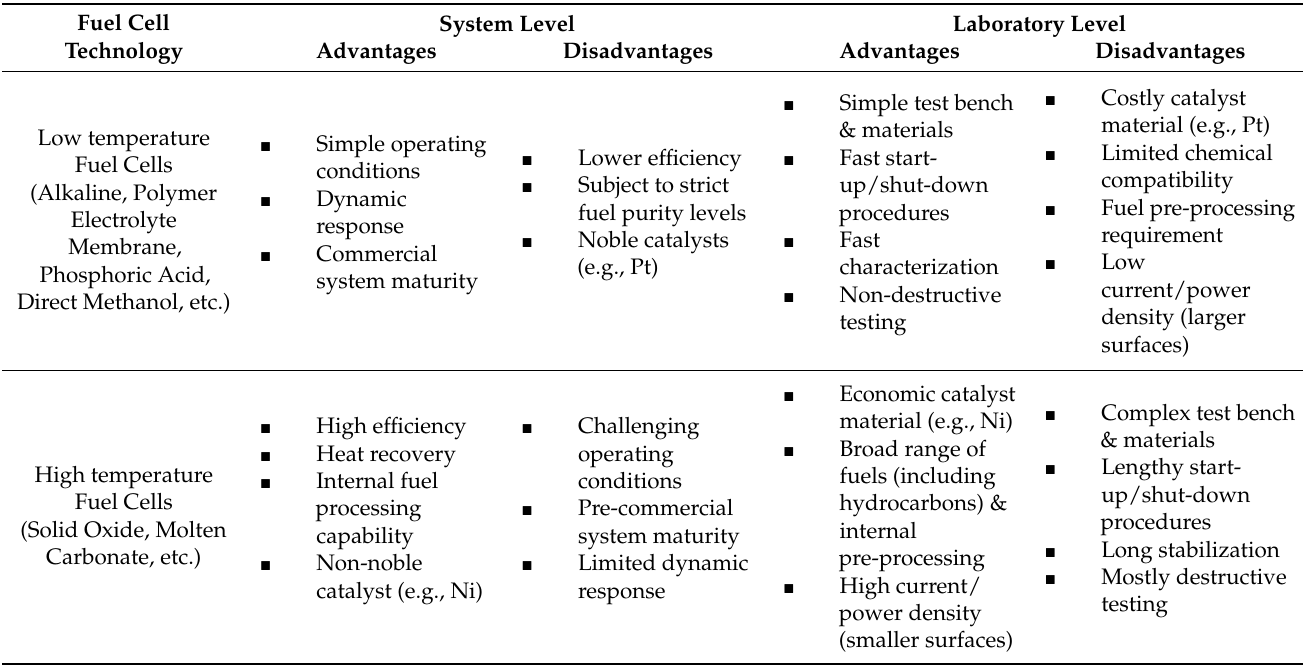
Table 1. Fuel Cell technologies overview. Advantages and disadvantages at system and laboratory level. Fuel Cell System Level Laboratory Level Technology Advantages Disadvantages Advantages